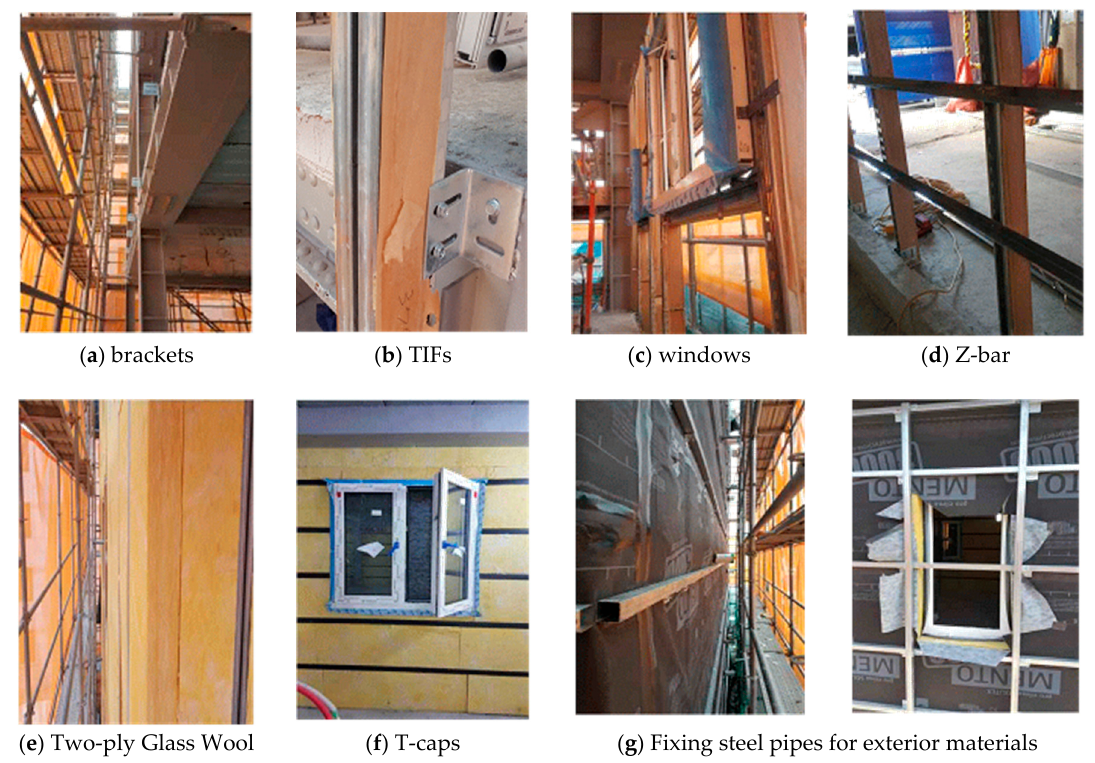
Figure 3. Construction of the TIF exterior insulation system on the curtain wall building.